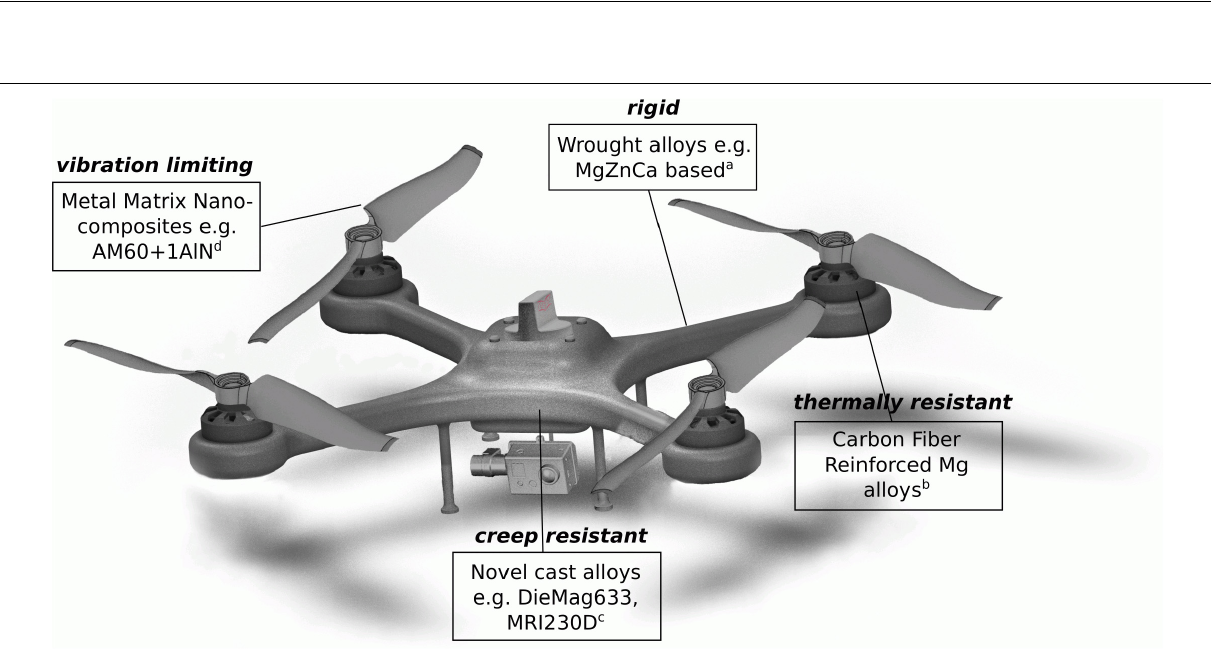
Frontiers in Materials |